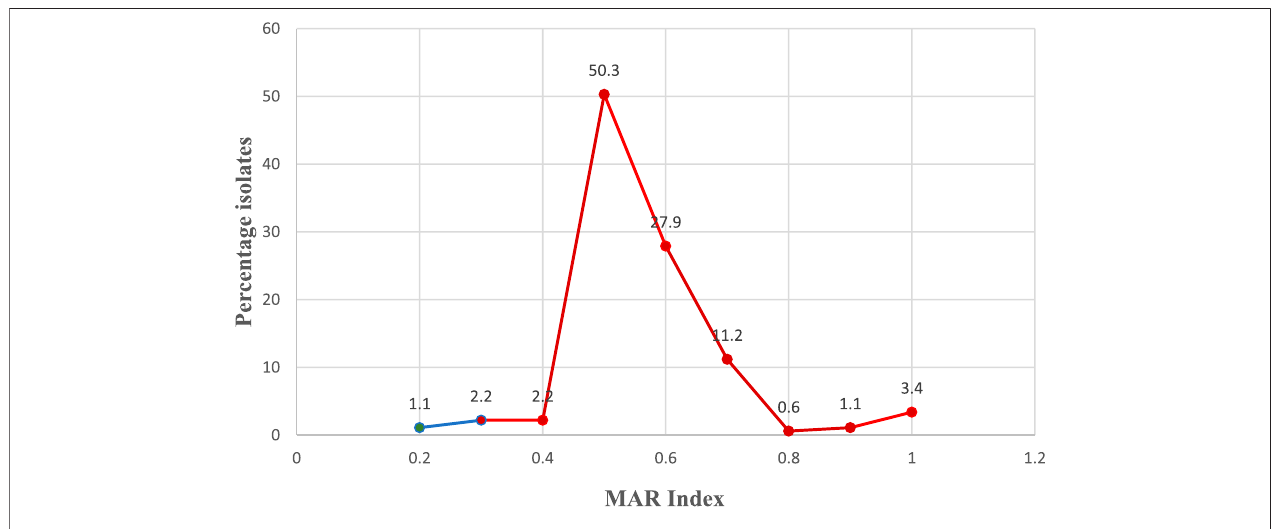
FIGURE 3 | Multiple antibiotic resistant index (MAR Index) of the VRE isolates and percentage involved. *Red zone revealed the epidemiological high-risk isolates zone (MAR Index > 0.2). The subsequent MAR Index value of the VRE isolates after 0.2 is 0.3 from which the red zone on the fi gure started.